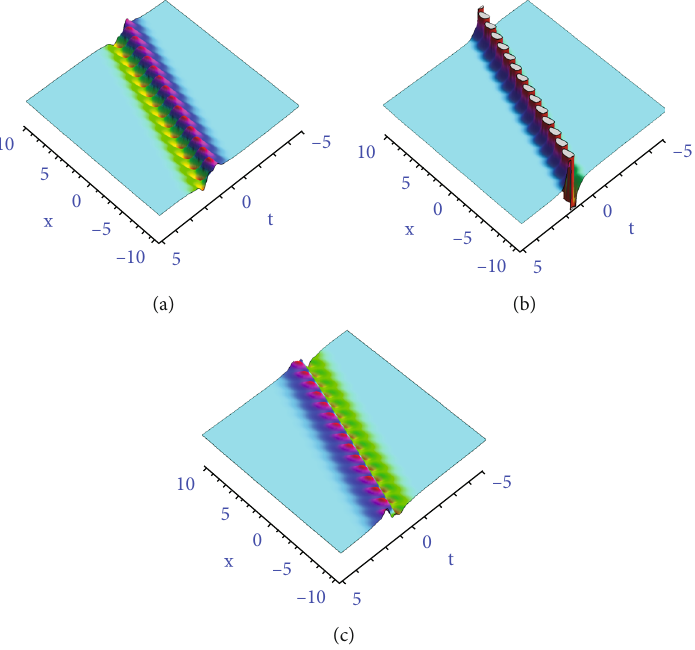
= α = α = α = k = 1 , k 1 4 11 9 1